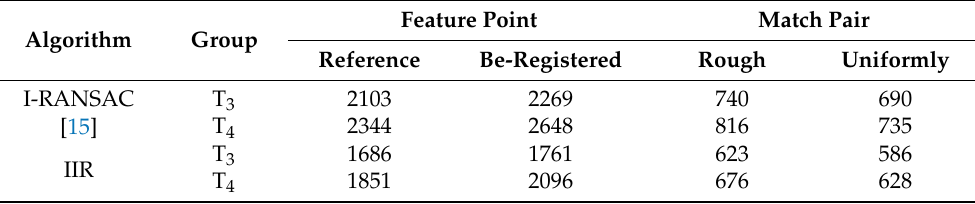
Table 6. A comparison of feature point information between two algorithms.